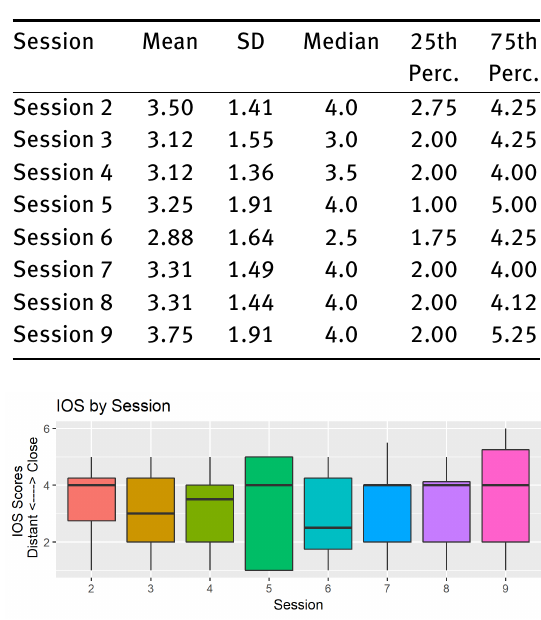
Table 6: Closeness to Agent across Sessions.